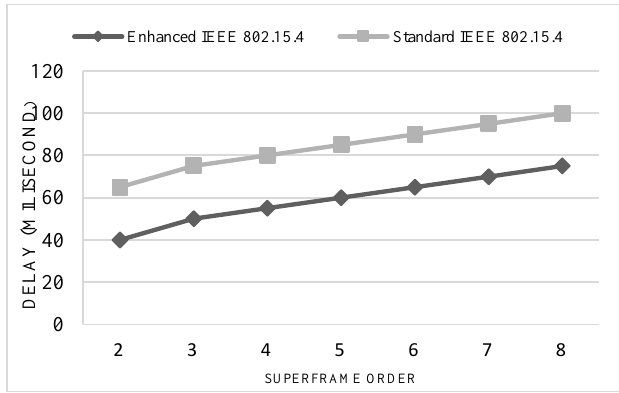
Fig. 8. Comparison between delay in IEEE 802.15.4 resulted from the original and our enhanced standard The detailed result summary of simulation is shown below in Table